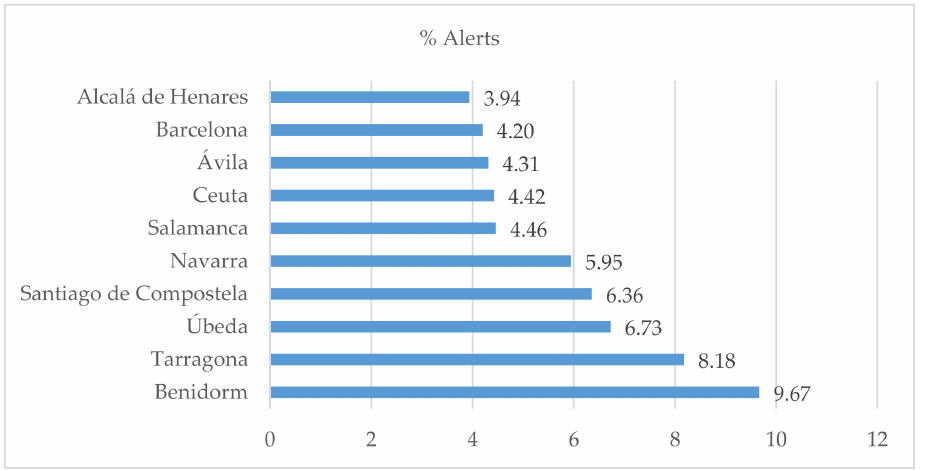
Figure 6. Percentage of alerts in the official tourism websites of the Tur4all accessible destinations analyzed in Spain and Portugal. Source: own elaboration from Wave